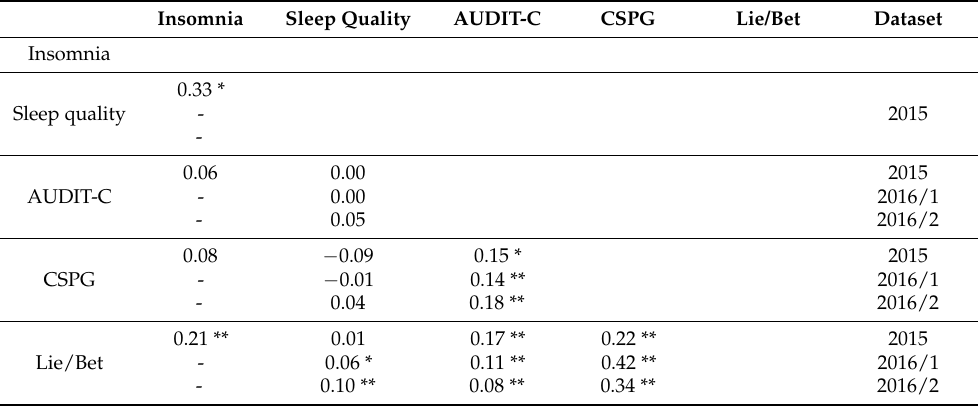
Table 3. Spearman’s Rho correlations between all variables across each dataset.